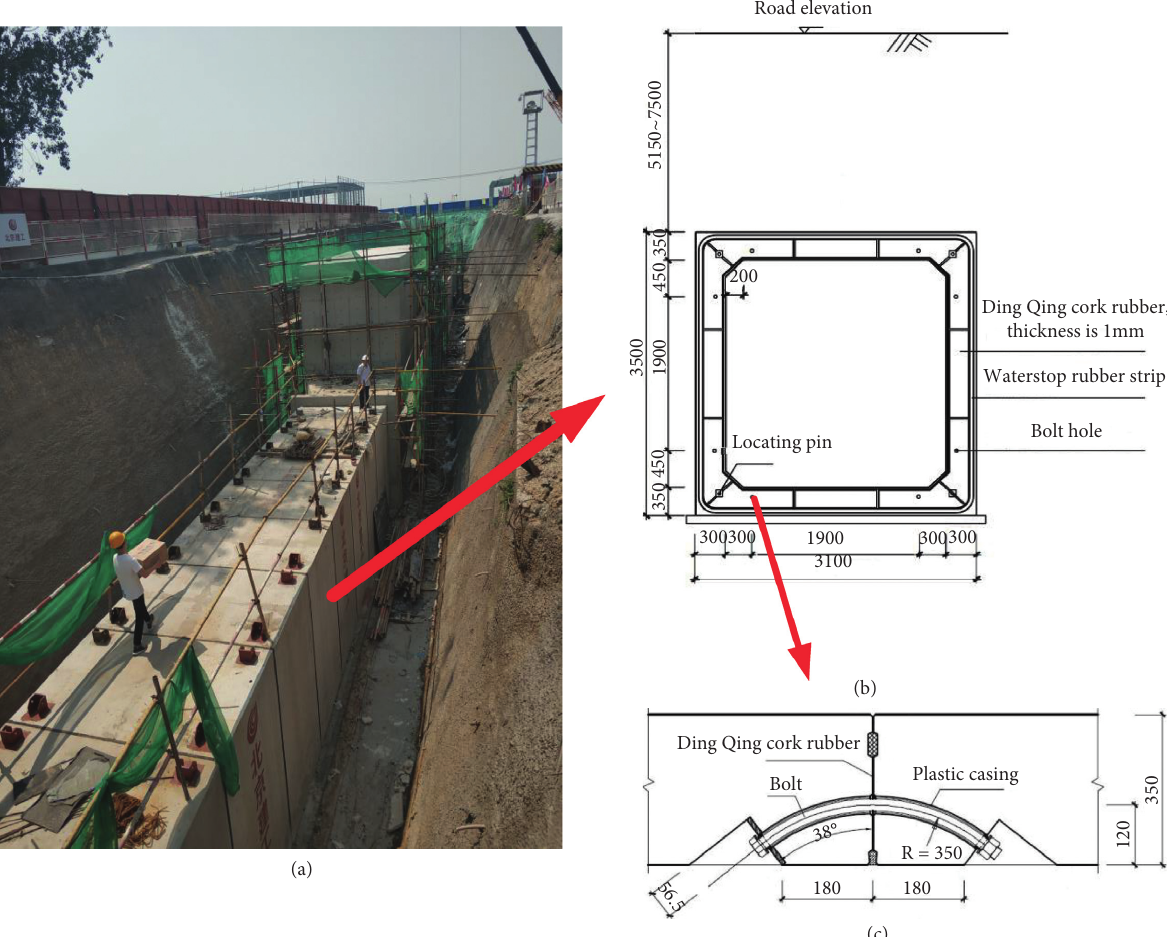
Figure 1: (a) Photography prefabricated UUT in Tongzhou District, Beijing. (b) Standard section. (c) Schematic diagram of the joint